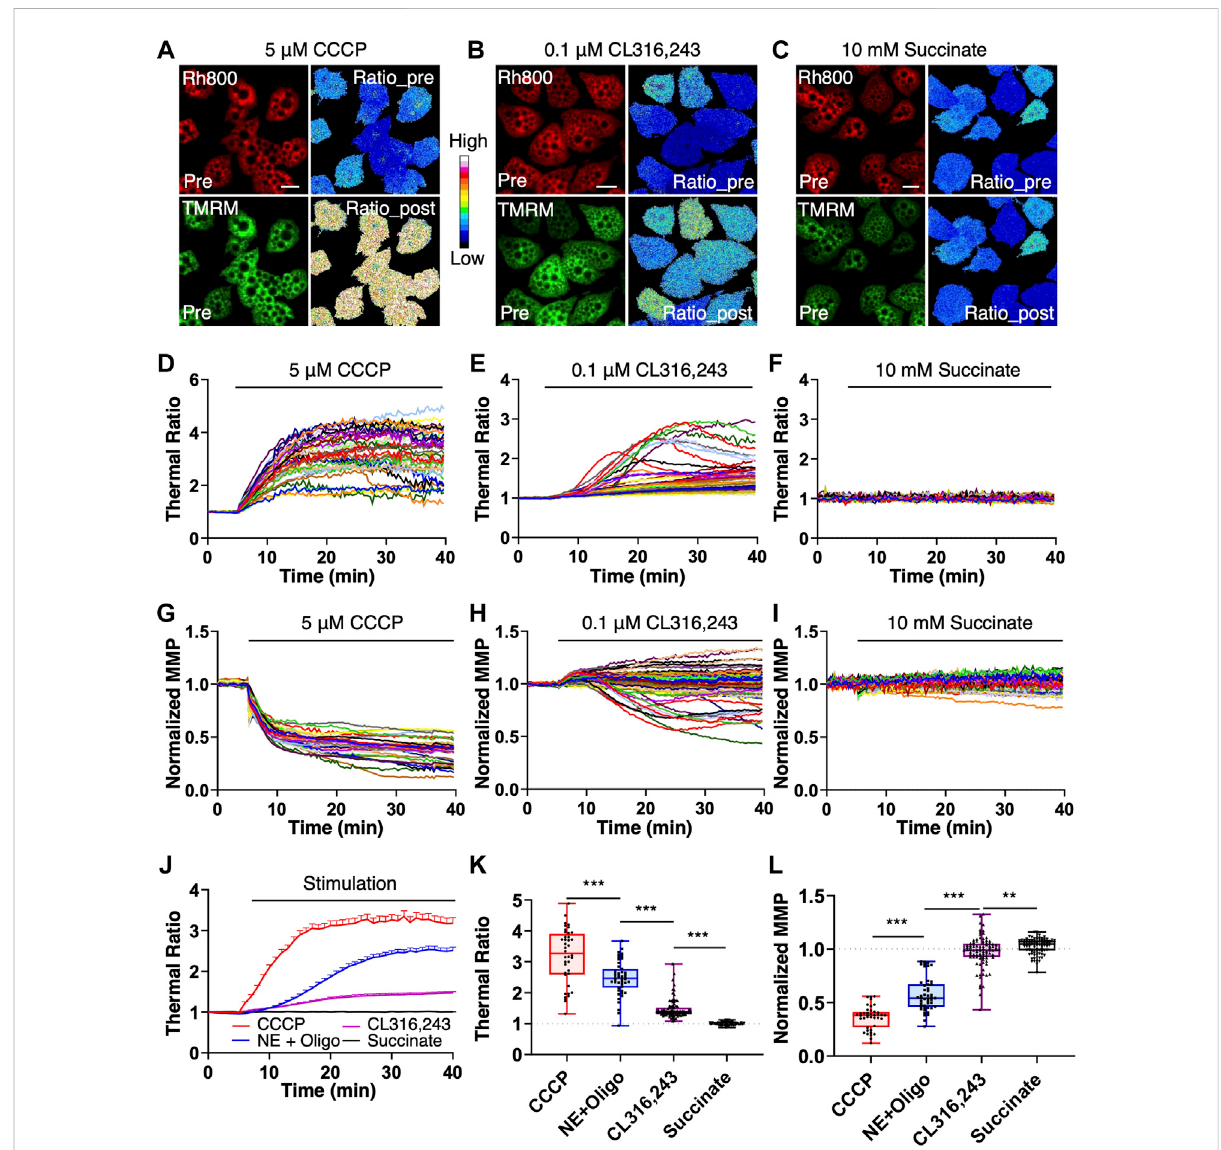
FIGURE 4 Endogenous thermogenic studies with the mitochondrial thermometry 2.0 in BA. (A – F) , the endogenous thermogenesis tests with the mitochondrial thermometry 2.0 in brown adipocytes. The pseudo-color ratios of Rh800 to TMRM represented thermogenic responses, and the fl uorescent intensity of Rh800 represented MMP. After 5 min of live cell imaging for the base line under resting condition, brown adipocyte was treated with 5 μ M of CCCP, 0.1 μ M of NE with 10 μ g ml-1 of oligomycin A pretreatment, 0.1 μ M of CL316,243 or 10 mM of succinate. Mitochondrial thermogenic responses and MMP dynamics were simultaneously imaged for data analyses (D – K) . (A – C) , were representative fl uorescent images (Rh800 and TMRM) and their pseudo-color thermal ratios of Rh800 to TMRM in brown adipocytes before and after the treatments of CCCP (A) , CL316,243 (B) or succinate (C) , respectively. Scale bars, 20 μ m. (D – F) , the thermogenic responses in brown adipocytes evoked byCCCP[ (D) ,n=41], CL316,243[ (E) ,n=91]orsuccinate [ (F) ,n=87],respectively. Eachcolored tracerepresentedasinglebrownadipocyte [in (D – F) ]. (A,D) ,thebrownadipocytestreatedwithCCCP (n=41)showed highthermogenicef fi ciency andlargeresponses. (B,E) ,demonstratedthe relatively low thermogenic ef fi cacy of CL316,243 (n = 91) in brown adipocytes. (C,F) , showed that succinate (n = 87) stimulation did not have thermogenic effect in brown adipocytes. (G – I) , the raw data plots of MMP changes in brown adipocytes treated with CCCP [ (H) , n = 41], CL316,243[ (I) ,n=91]orsuccinate[ (G) ,n=87].Eachcoloredcurverepresentedasinglebrownadipocyte. (G) ,theresultsshowedthedepolarization of MMP in brown adipocytes treated with CCCP (n = 41). (H) , there were two populations of MMP changes (hyperpolarization and depolarization) in brown adipocytestreated with CL316,243 (n = 91). (I) , succinatetreatment didn ’ taffect MMP inbrown adipocytes. (J) , thesummary and comparison oftheaveragedthermogenicresponsesofbrownadipocytesevokedbyCCCP(redline,n=41),NEandoligomycinAco-treatment(blueline,n=47), CL316,243 (purple line, n = 91) or 10 mM succinate (black line, n = 87). (K) , scatter plotting the thermogenic ratio values with boxplots for CCCP (red box,n=41), NE+ Oligomycin A(blue box,n=47),CL316,243(purplebox,n=91)andsuccinate(black box,n=87)treatmentson brownadipocytes. (L) , scatter plotting the normalized MMP with boxplots under the stimulations of CCCP (red box, n = 41), NE + Oligomycin A (blue box, n = 47), CL316,243 (purple box, n = 91) and succinate (black box, n = 87). In (K,L) , each point represented a single brown